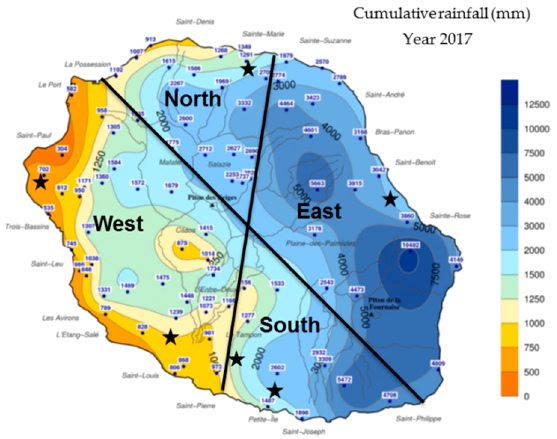
Figure1. MapofReunionIslandwithsamplinglocations(blackstars). Fourlocationsweredi ff erentiated Figure 1. Map of Reunion Island with sampling locations (black stars). Four locations were based on annual cumulative rainfall on year 2017. Source: Meteo differentiated based on annual cumulative rainfall on year 2017. Source: Meteo France.